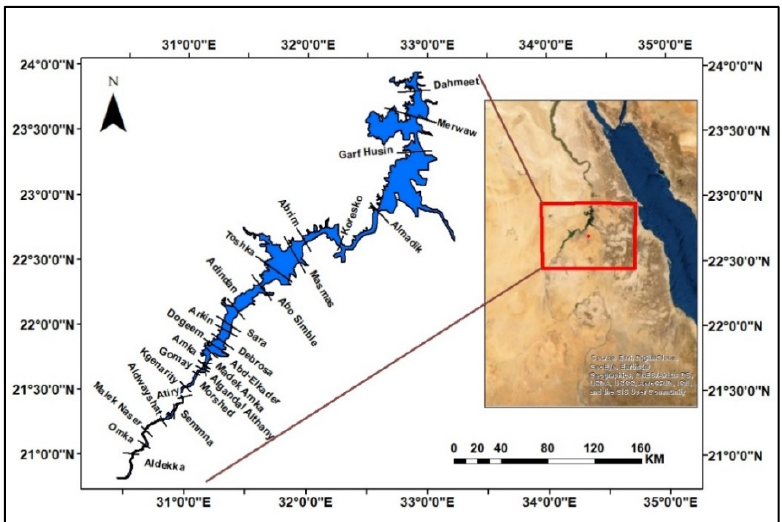
Figure 2. Location map of Lake Nasser.